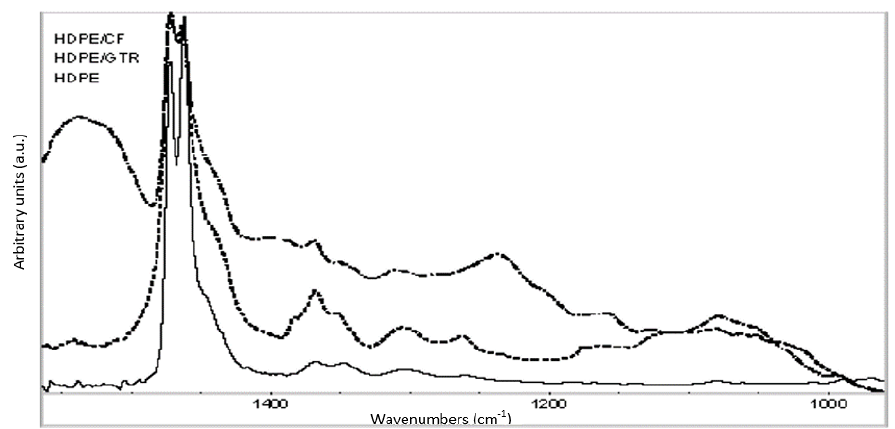
Figure 5. FTIR spectra of HDPE matrix and composites HDPE/GTR40 and HDPE/CFs40.